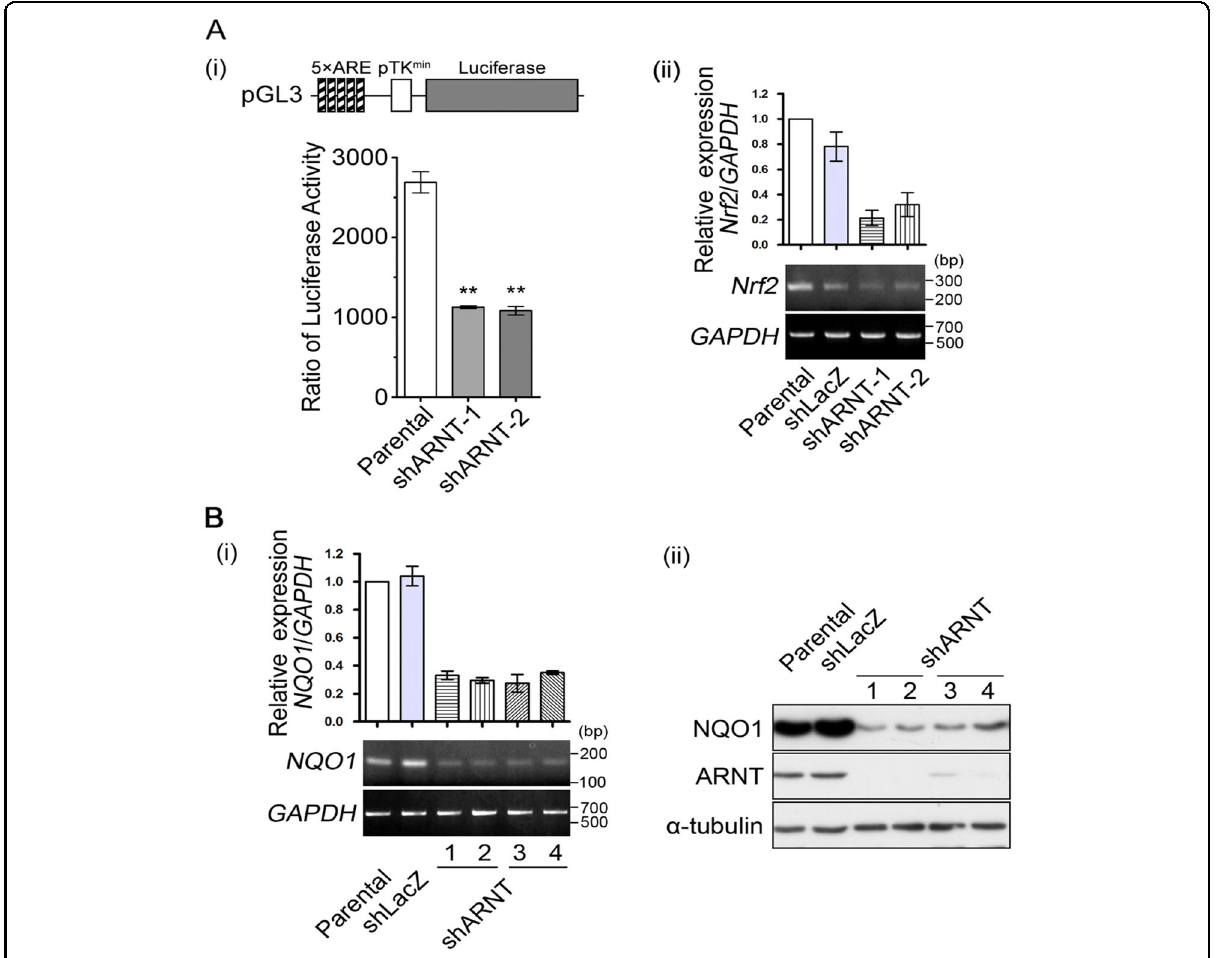
Fig. 3 The depletion of ARNT represses NQO1 expression. A The construct containing the pTK promoter with 5 repeats of the antioxidant response element (ARE) 57 and bearing the luciferase gene is presented (i). A375 cells were transfected with 0.5 μ g of plasmid by lipofection for overnight. Luciferase activity and protein concentrations were then determined and normalized (i). Values represent the mean ± s.e.m of three determinations. ** P < 0.01. Gene expression of Nrf2 was analyzed in shARNT cells by quantitative real-time PCR (upper panel) and RT-PCR (lower panel). Total RNA was extracted for reverse transcription PCR with Nrf2 and glyceraldehyde-3-phosphate dehydrogenase ( GAPDH ) primers (ii). B Gene expression of NQO1 was analyzed in cells by quantitative real-time PCR (upper panel) and RT-PCR (lower panel) (i). Expressions of NQO1, ARNT and α -tubulin were evaluated by Western blotting with antibodies against NQO1, ARNT and α -tubulin in shARNT A375 cells